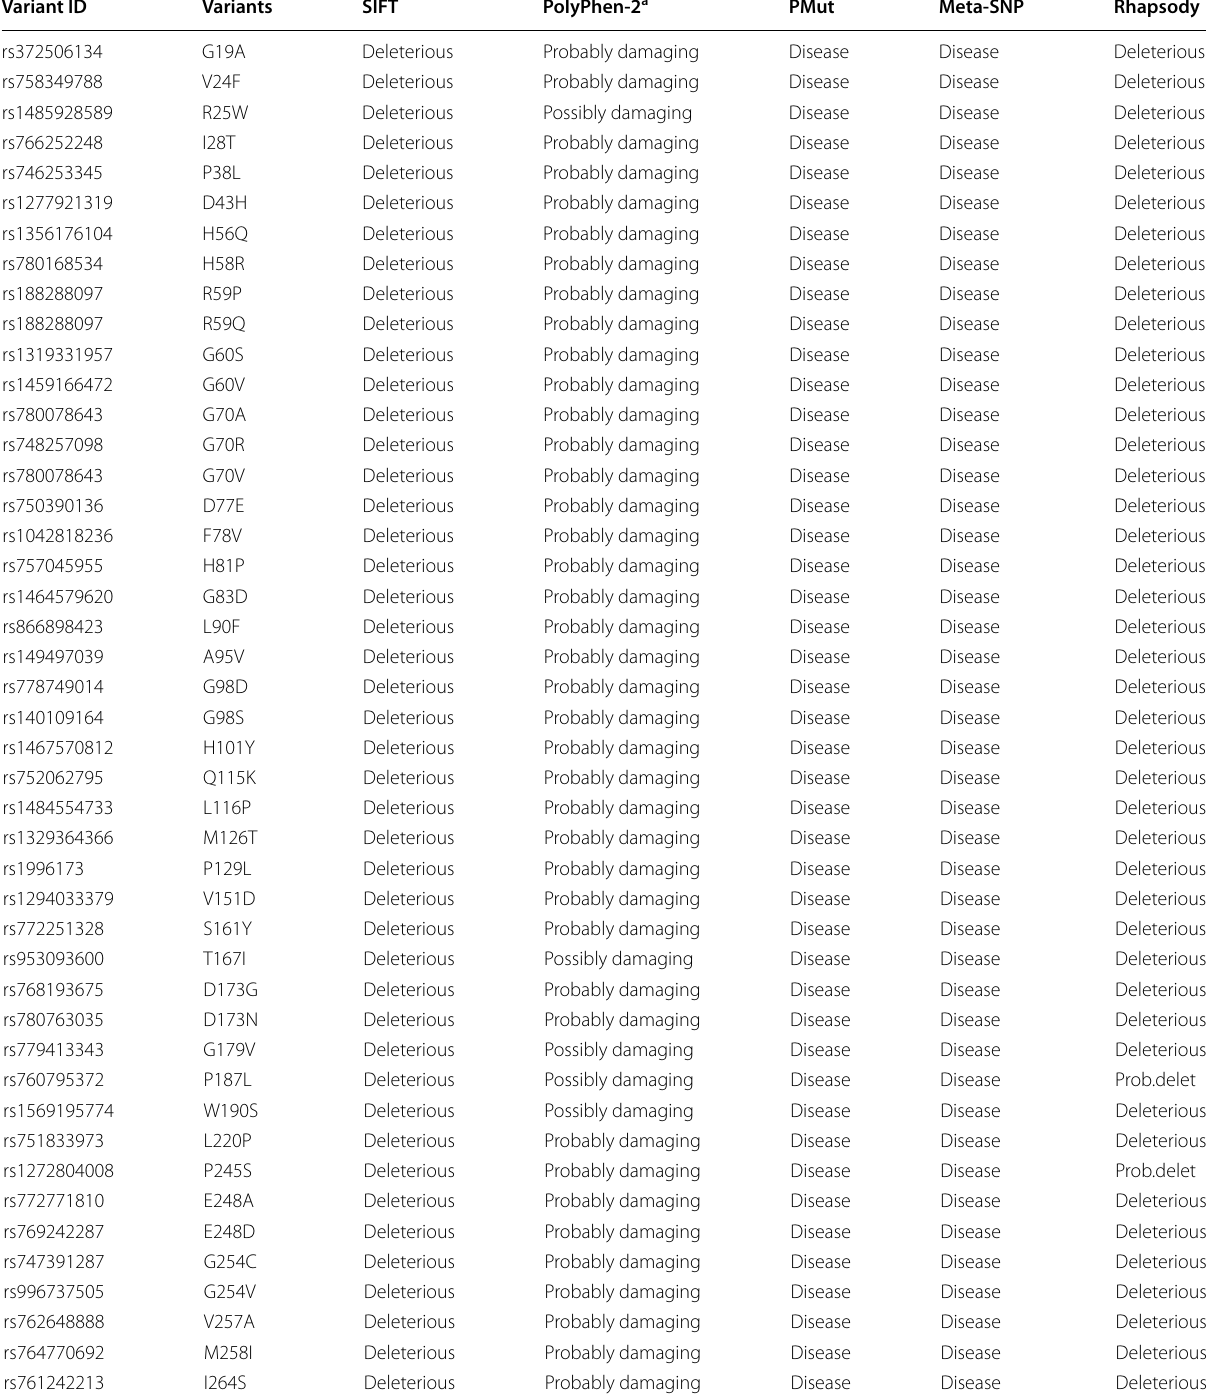
a PolyPhen-2 classifies variants as benign, possibly damaging and probably damaging. Only those variants that were predicted to be “probably damaging” were considered to be harmful to increase the accuracy of